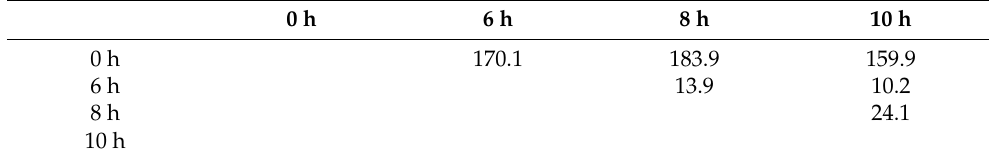
Table 5. Tukey test of the data in Table 3.